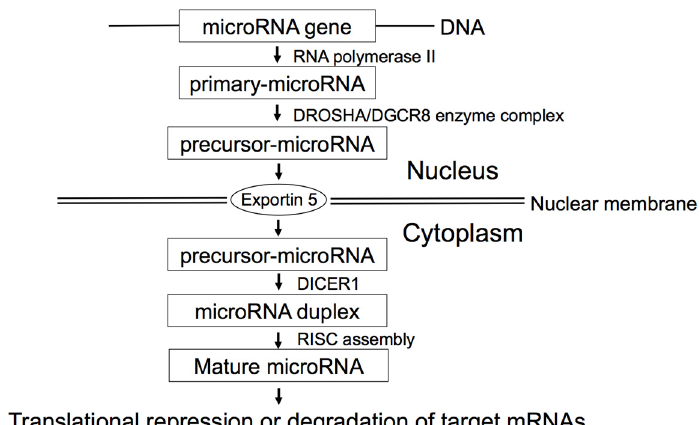
Figure 1. MicroRNA biogenesis. MicroRNAs are initially transcribed by RNA polymerase II as primary ‐ microRNAs with hairpin structures. DROSHA/DGCR8 enzyme complex then cleaves primary ‐ microRNAs into precursor ‐ microRNAs, which are transported to cytoplasm by Exportin 5, and cleaved by DICER to form microRNA duplexes. One strand is selected to function as a mature microRNA and loaded into the RNA ‐ induced silencing complex (RISC), whereas the partner microRNA* is preferentially degraded. The mature microRNA with RISC binds to 3 ′ UTR of target mRNA resulting in translational repression or degradation.